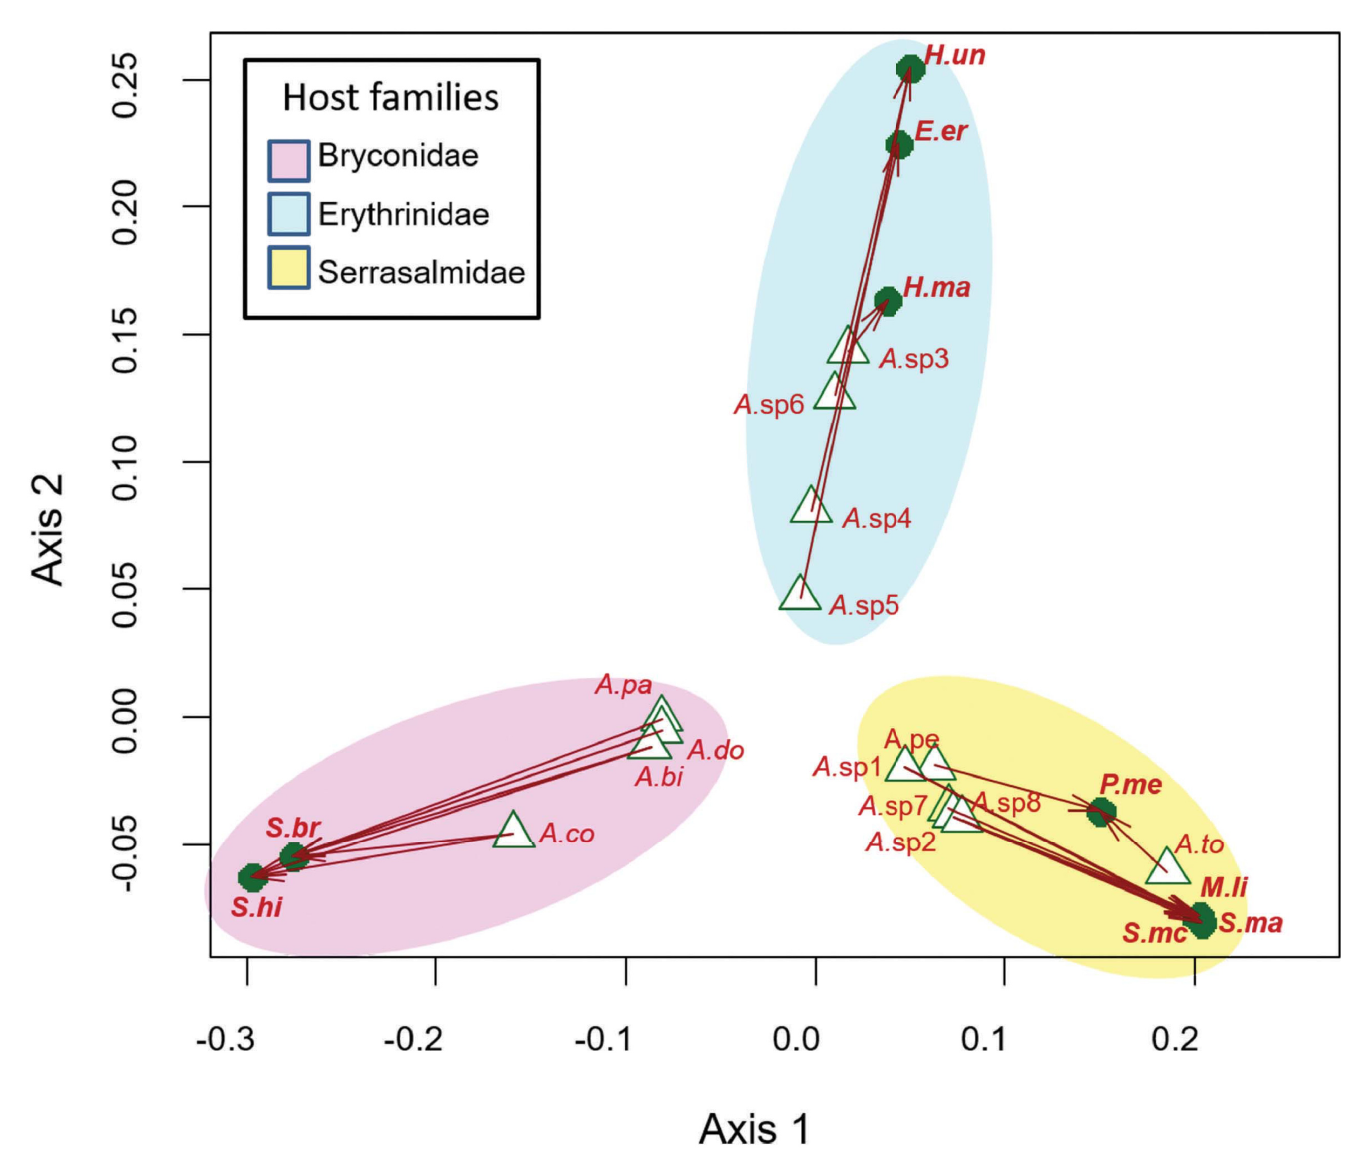
Fig 4. Procrustean superimposition plot which minimizes the differences between the principal coordinates of patristic distances of Anacanthorus spp. and their Characiformes hosts. For each vector, the starting point (triangles) represent the configuration of Anacanthorus spp. and the arrowhead (points) the configuration of the corresponding hosts. The vector length represents the global fit (residual sum of squares) which is inversely proportional to the topological congruence. Host associations were grouped according to host families. Abbreviations of species names are the same as in Fig 3.